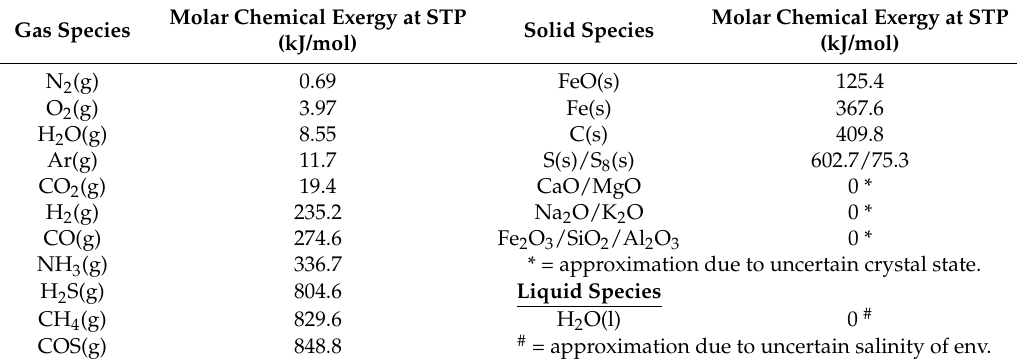
Table 2. Chemical exergy of species at